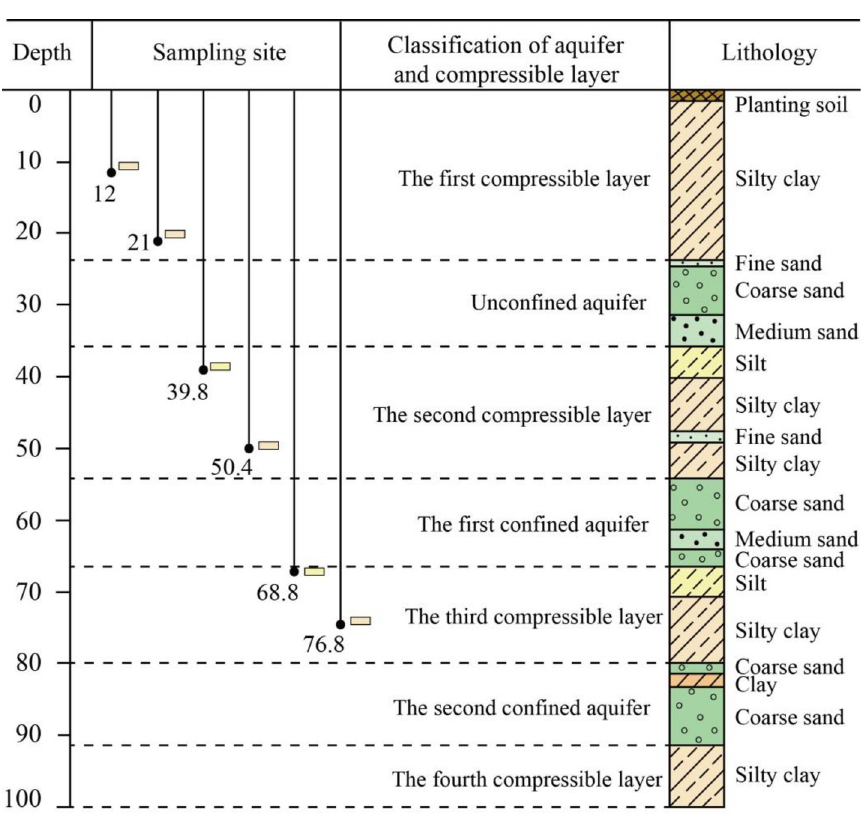
Fig 2. Schematic description of the borehole BH1, showing the lithological profile in depth of 100 m and vertical location of six soil samples.